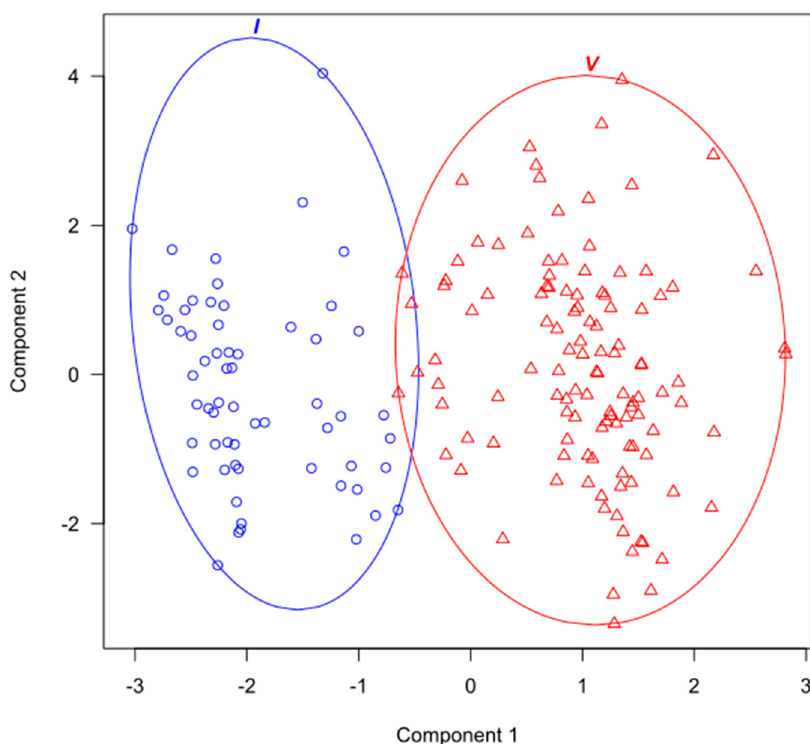
Figure A1. Cluster plot of the two separated groups I (blue) and V (red). The cluster analysis resulted in two nearly non-overlapping groups. The pigs without lesions (group I) were clearly separable from the pigs with many long-lasting scores of “1” (group V).